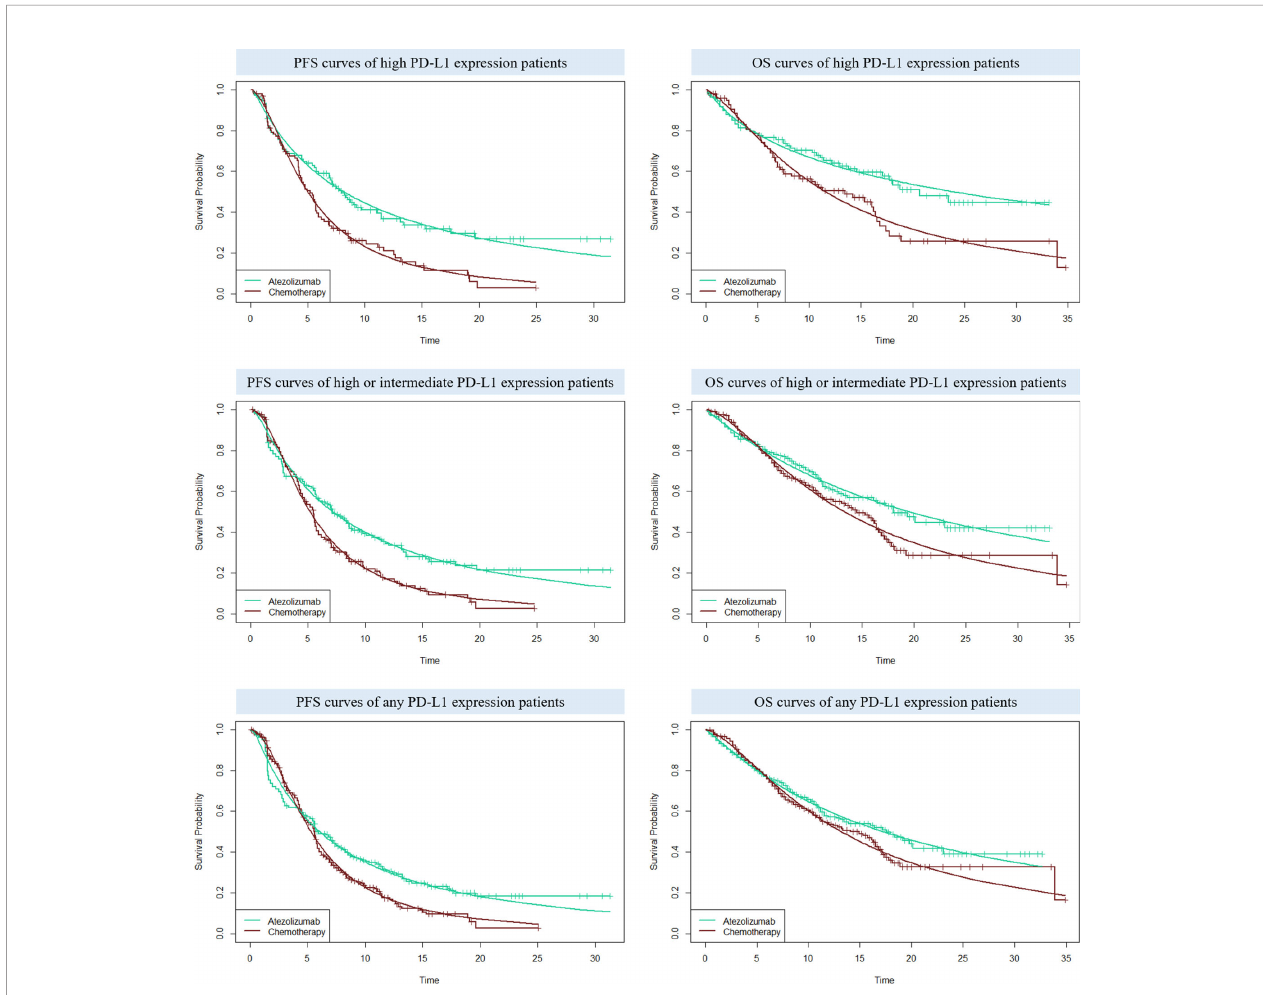
FIGURE 2 | The comparison between the adopted fi tting curves and the Kaplan-Meier (KM) curves in IMpower110 trial. PFS, progression-free survival; OS, overall survival; PD-L1, programmed death ligand 1.